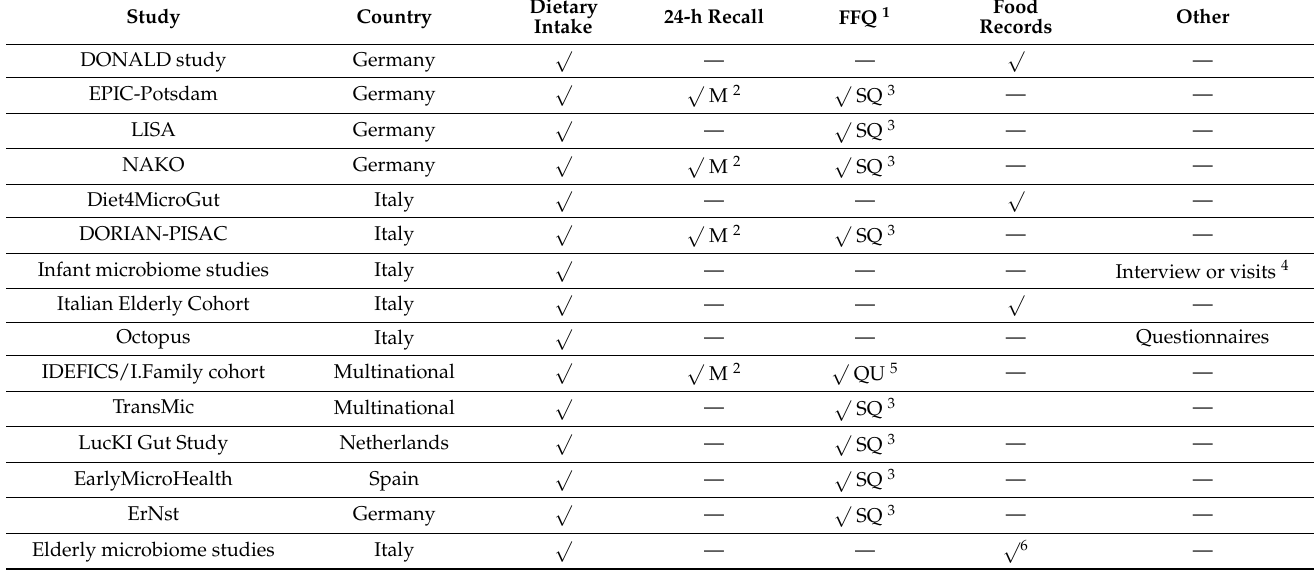
Methods used for dietary assessments in the identified observational studies participating in the KP- INTIMIC